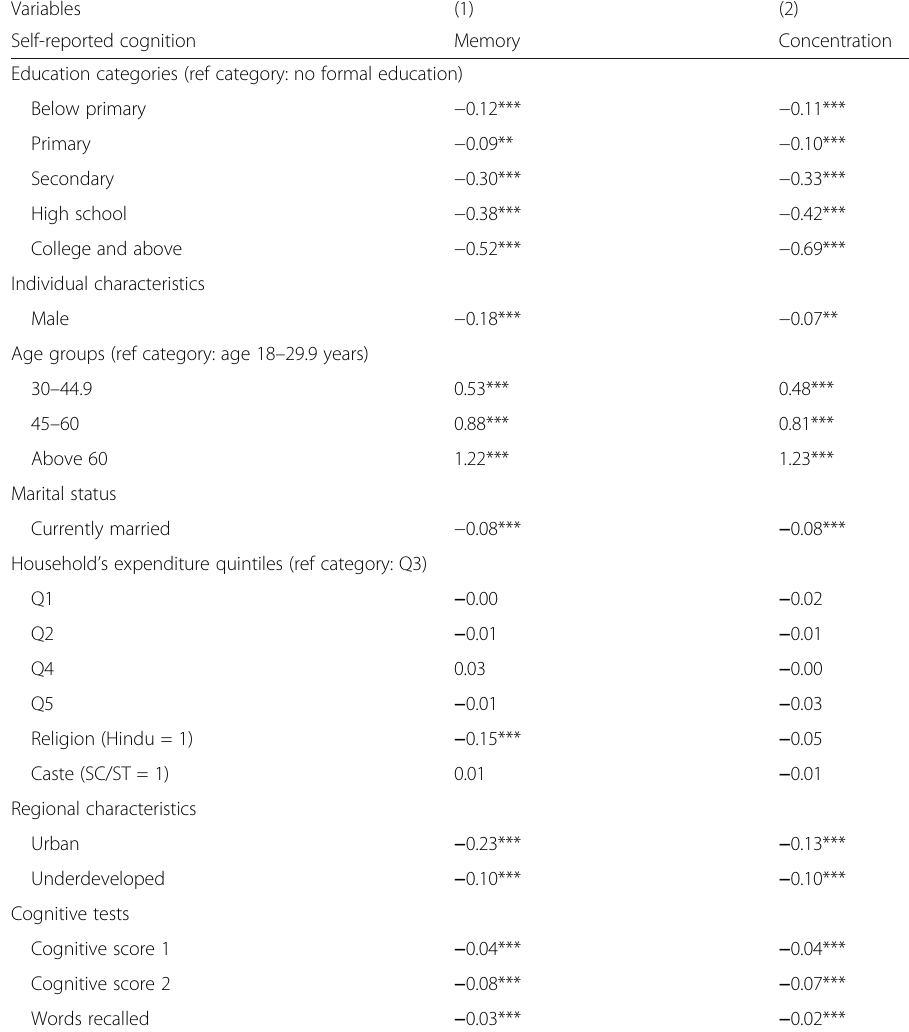
Table 9 Dependent variable: self-reported cognitive difficulty Variables (1) (2) Self-reported cognition Memory